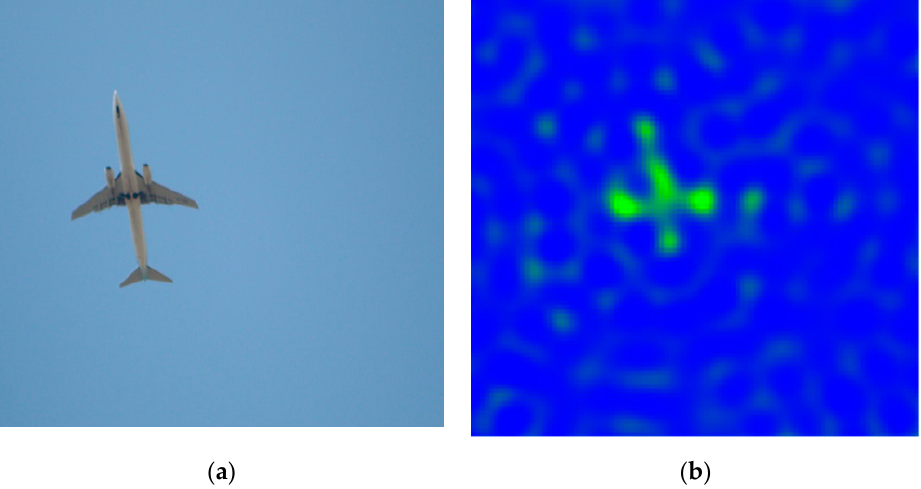
Figure 9. Visibility function calibration process. ( a ) is the raw visibility function, ( b ) is the visibility function after calibration for phase error, and ( c ) is the visibility function after calibration for magnitude error.